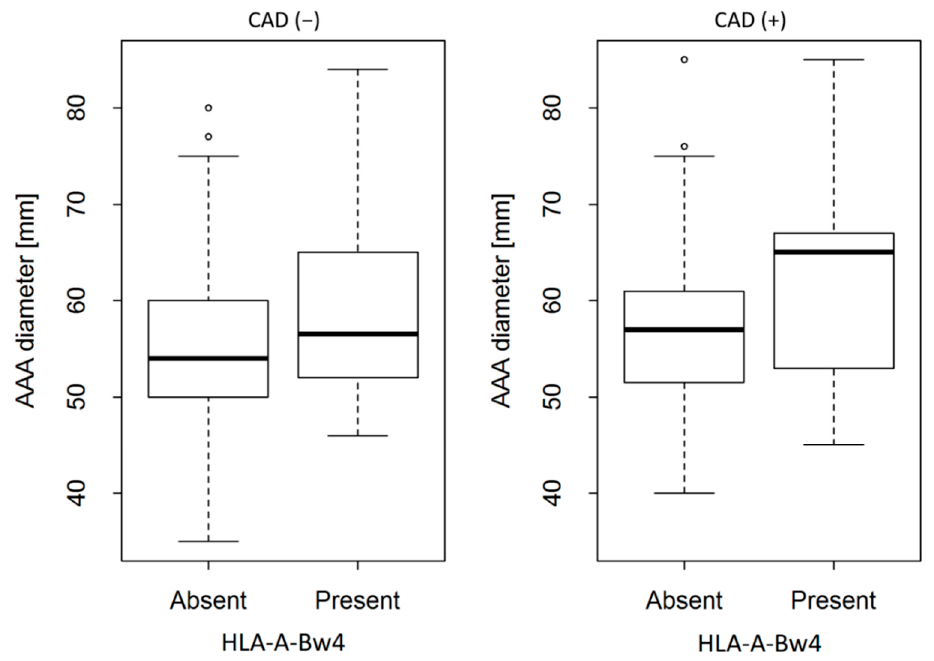
Figure 2. Differences between AAA diameter subdivided according to the presence of HLA-A-Bw4 and CAD ( p = 0.008). For CAD ( − ) and CAD (+), see legend to Figure 1.